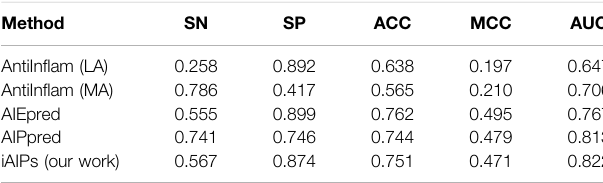
TABLE 6 | Performance of different identi fi cation models on the independent dataset.